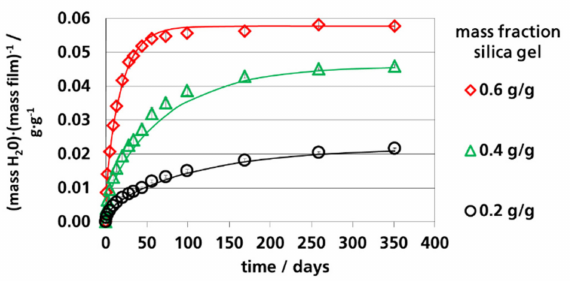
Figure 7. Water vapor absorption of films with dispersed silica gel at 52% RH and 23 ◦ C, lines: Calculated using Equation (2) ( n = 100).